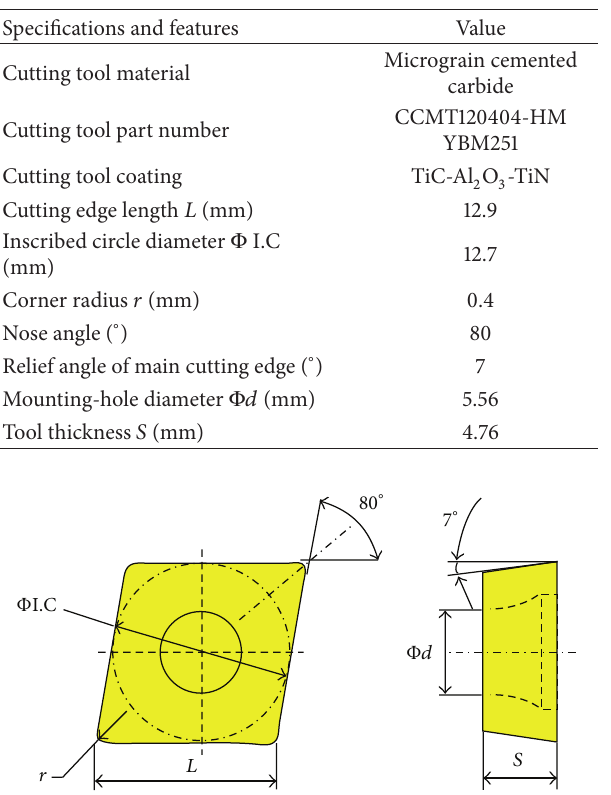
Table 3: Mechanical specifications and features of cutting tool.